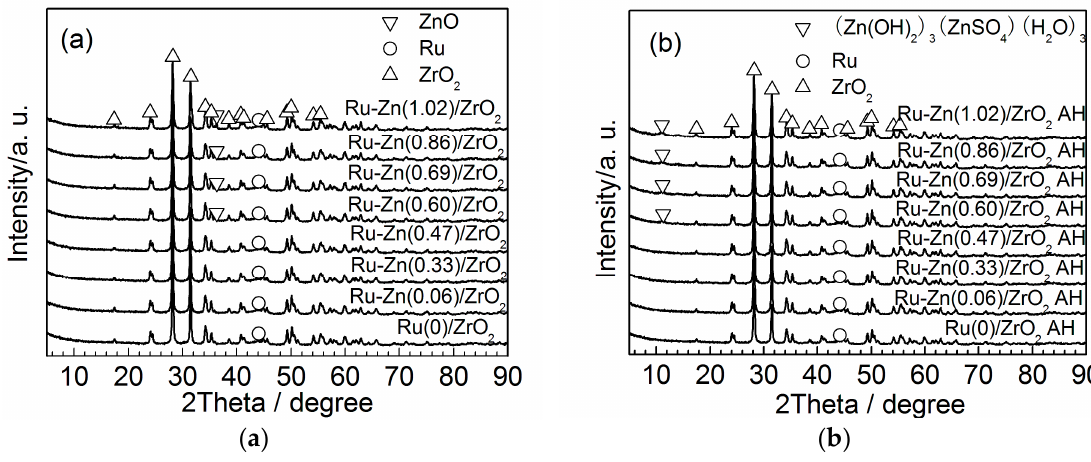
Figure 1. XRD patterns of Ru-Zn(x)/ZrO 2 before ( a ) and after hydrogenation ( b ).